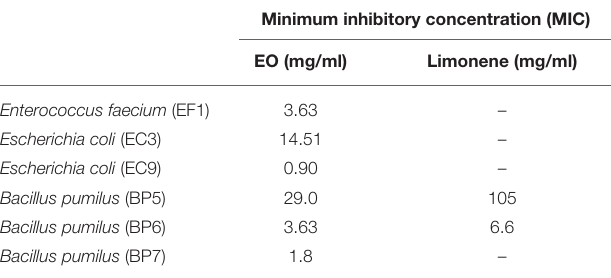
TABLE 1 | Minimal inhibitory concentration (MIC) of EO and limonene.